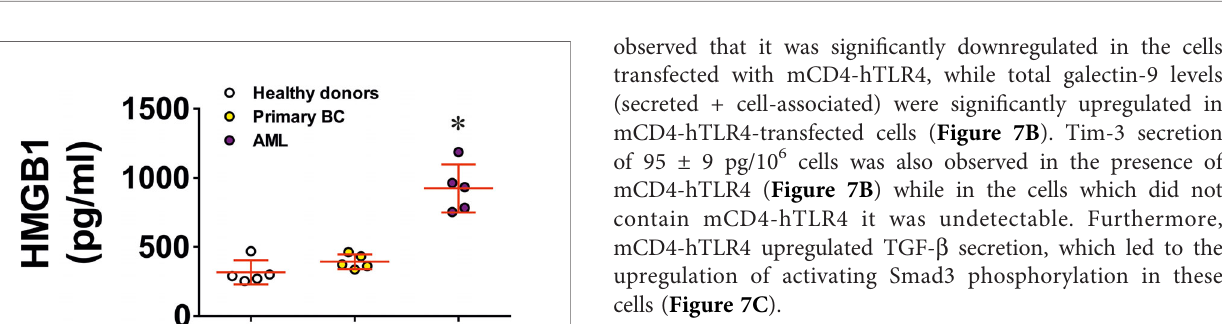
FIGURE 5 | The effects of HMGB1 on Galectin-9 and Tim-3 expression in HEK293 human embryonic kidney cells. MCF-7 cells were exposed for 24 h to 1 µg/ml HMGB1 followed by measurement of TGF- b secretion and Smad3 activating phosphorylation (A) , galectin-9 protein expression and secretion (B) , galectin-9 cell surface presence (C) and Tim-3 protein expression and release (D) . Images are from one experiment representative of four which gave similar results. Quantitative data are shown as mean values ± SEM of four independent experiments.